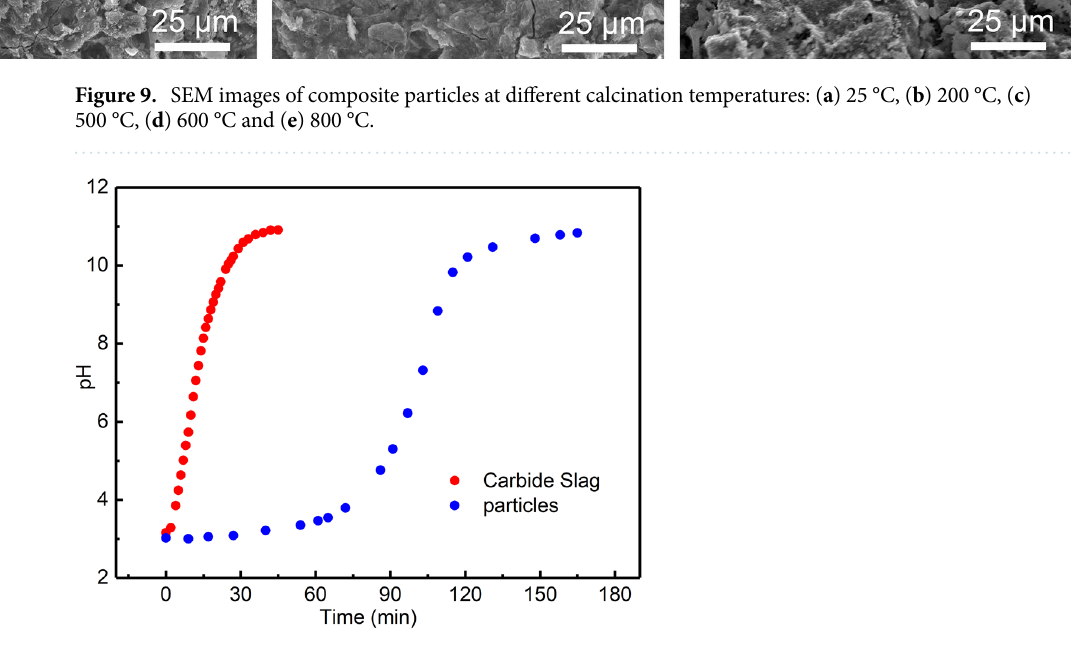
Figure 10. Alkalinity release rates of optimal composite particles and carbide slag